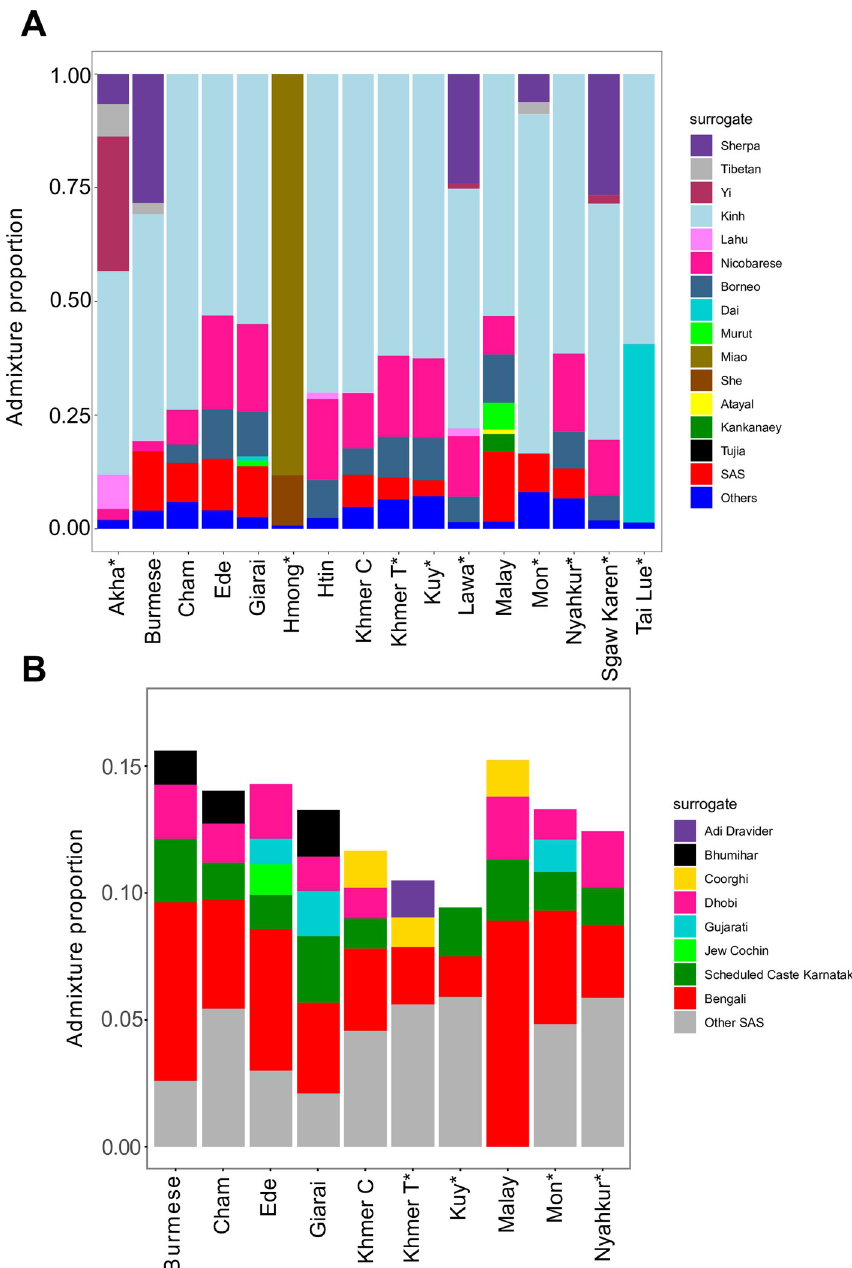
Fig 7. Admixture proportions inferred using SOURCEFIND. ( A ) Admixture proportions from all surrogates contributing at least 1% of target population’s ancestry. The sum of ancestry proportions from all other surrogates is labeled as Others. ( B ) The same results are shown for SAS surrogates only. Asterisks after population names indicate that these populations are newly genotyped in this study. Sino-Tibetan surrogates, namely Yi, Tibetan, Lahu, and Sherpa. Sherpa contributes more than 20% of ancestry in Burmese, Sgaw Karen, and Lawa. About 10% of Mon ancestry is derived from Sherpa and Tibetans (Fig 7A). SOURCEFIND also detected SAS admixture in Burmese, Khmer from Cambodia and Thailand, Cham, Ede, Giarai, Kuy, Malay, Nyahkur, and Mon